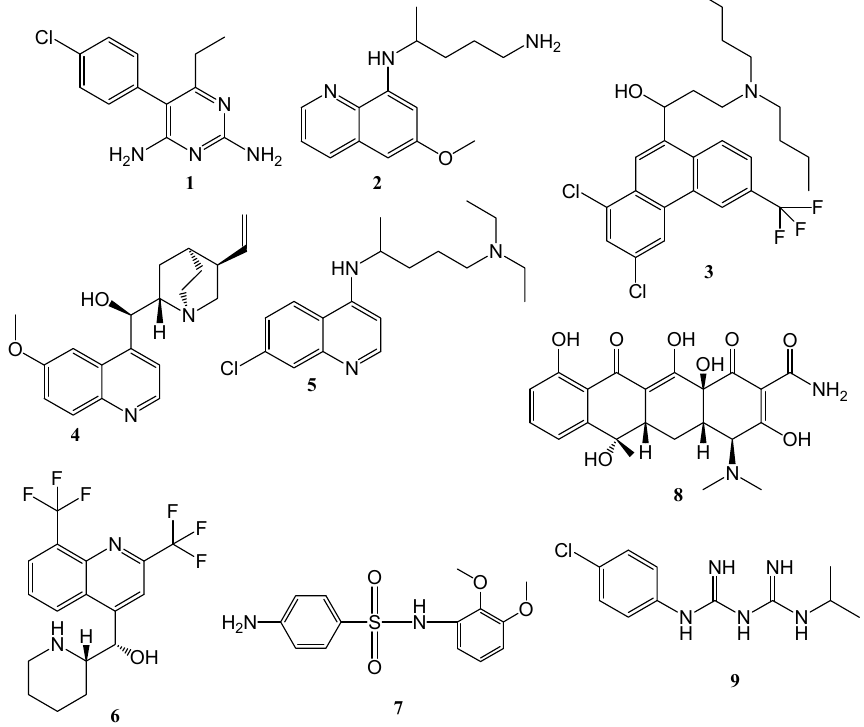
Figure 1. Examples of antimalarials classified based on their activity against malaria life stage.